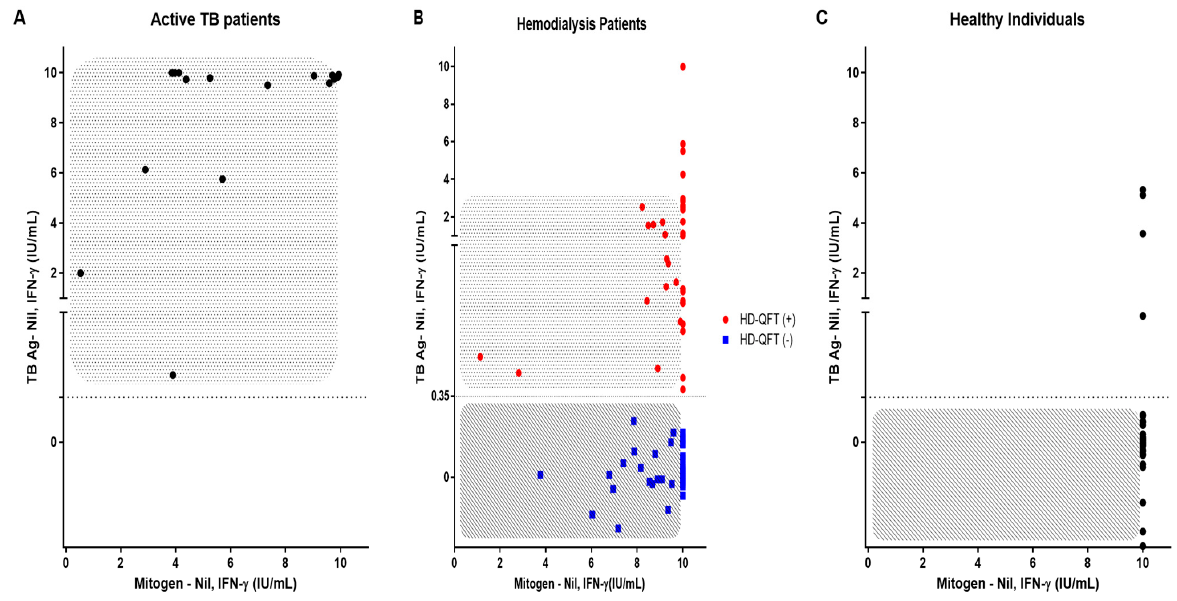
Figure 3. Comparison of results from MTB-specific Ag stimulated IFN- γ levels and PHA-stimulated IFN- γ levels between Active TB patients ( A ) hemodialysis patients ( B ) and healthy individuals ( C ). Note: Correlation data of IFN- γ stimulated with PHA and MTB-specific antigens in hemodialysis patients: red scatter dot is HD with QFT-positive group and blue scatter dot is HD with QFT-negative group; gray box: the part of abnormal T cell capability (85% in active TB patients group, 41.2% in HD with QFT-positive group, 38.8% in HD with QFT-negative group, and no one in HI group).